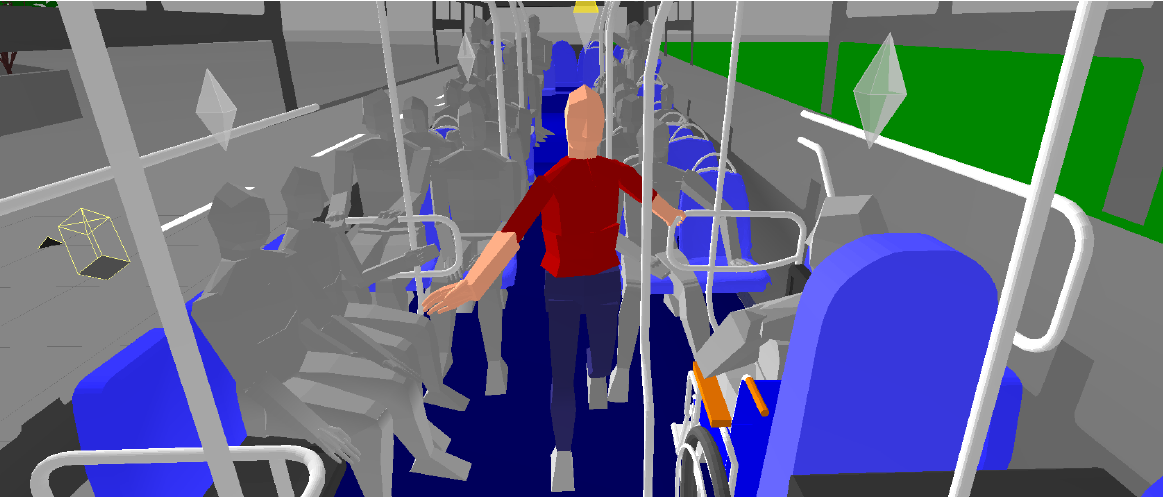
Figure 8. P13 moves forwards maintaining grip of the left hand handle but finds there is no conveniently placed right hand